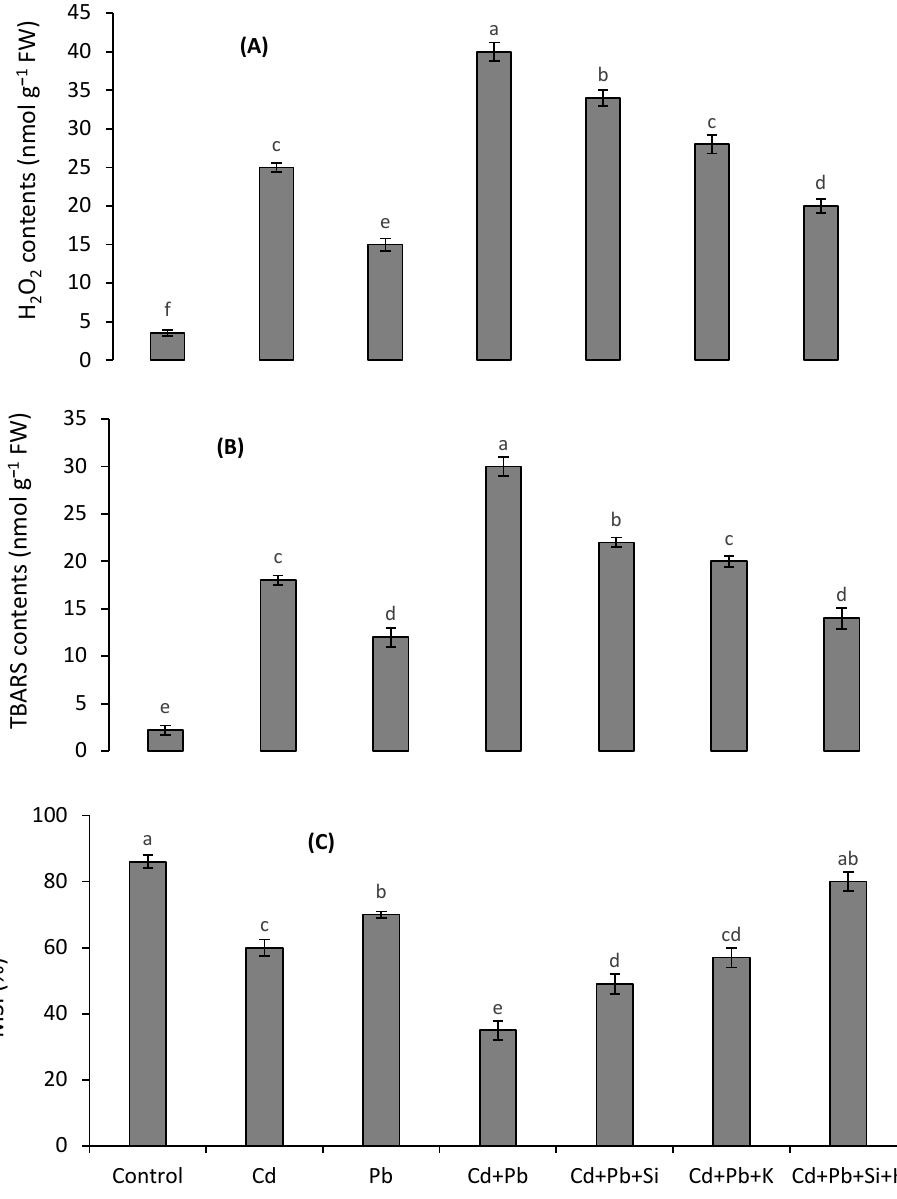
Figure 1. Effects of different Cd and Pb treatments on H 2 O 2 contents ( A ), TBARS contents ( B ) and MSI ( C ) on quinoa with and without supplementation with Si and K. Bars with different letters indicate a significant difference among the treatments at 5% significance level.